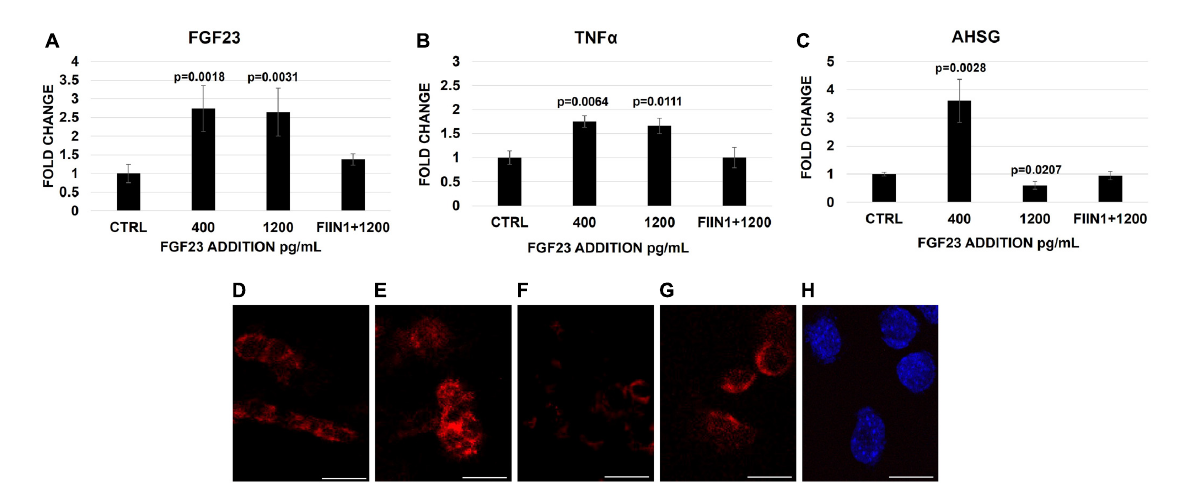
FIGURE1 Changes of FGF23 (A) , TNF α (B) , and AHSG (C) mRNA expression 24 h after the addition of FGF23 at 400 pg/ml and then at 1,200 pg/ml without and with FIIN 1 hydrochloride (FIIN1) in HepG2. FISH of AHSG mRNA in the ctrl (D) and 24 h after the addition of FGF23 at 400 pg/ml (E) and 1,200 pg/ml without (F) and with FIIN1 (G) in HepG2 and podocytes (H) as negative ctrl. N = 4 (A–C) . Scale bar 50 µ